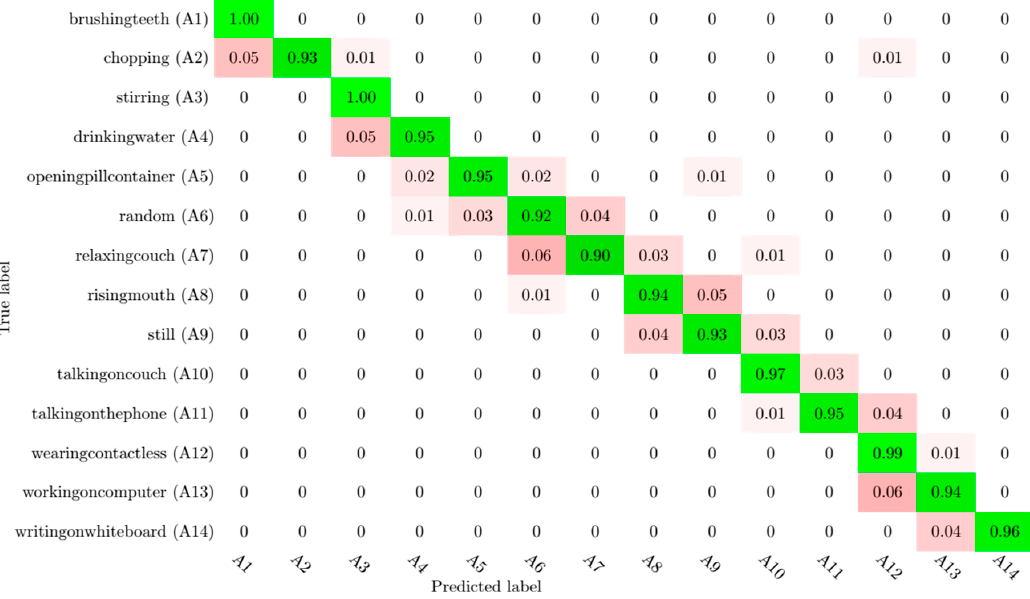
Figure 7. Confusion matrix of the proposed human activity recognition system. The true labels are presented in the rows, and the labels predicted by the proposed model are presented in the columns.